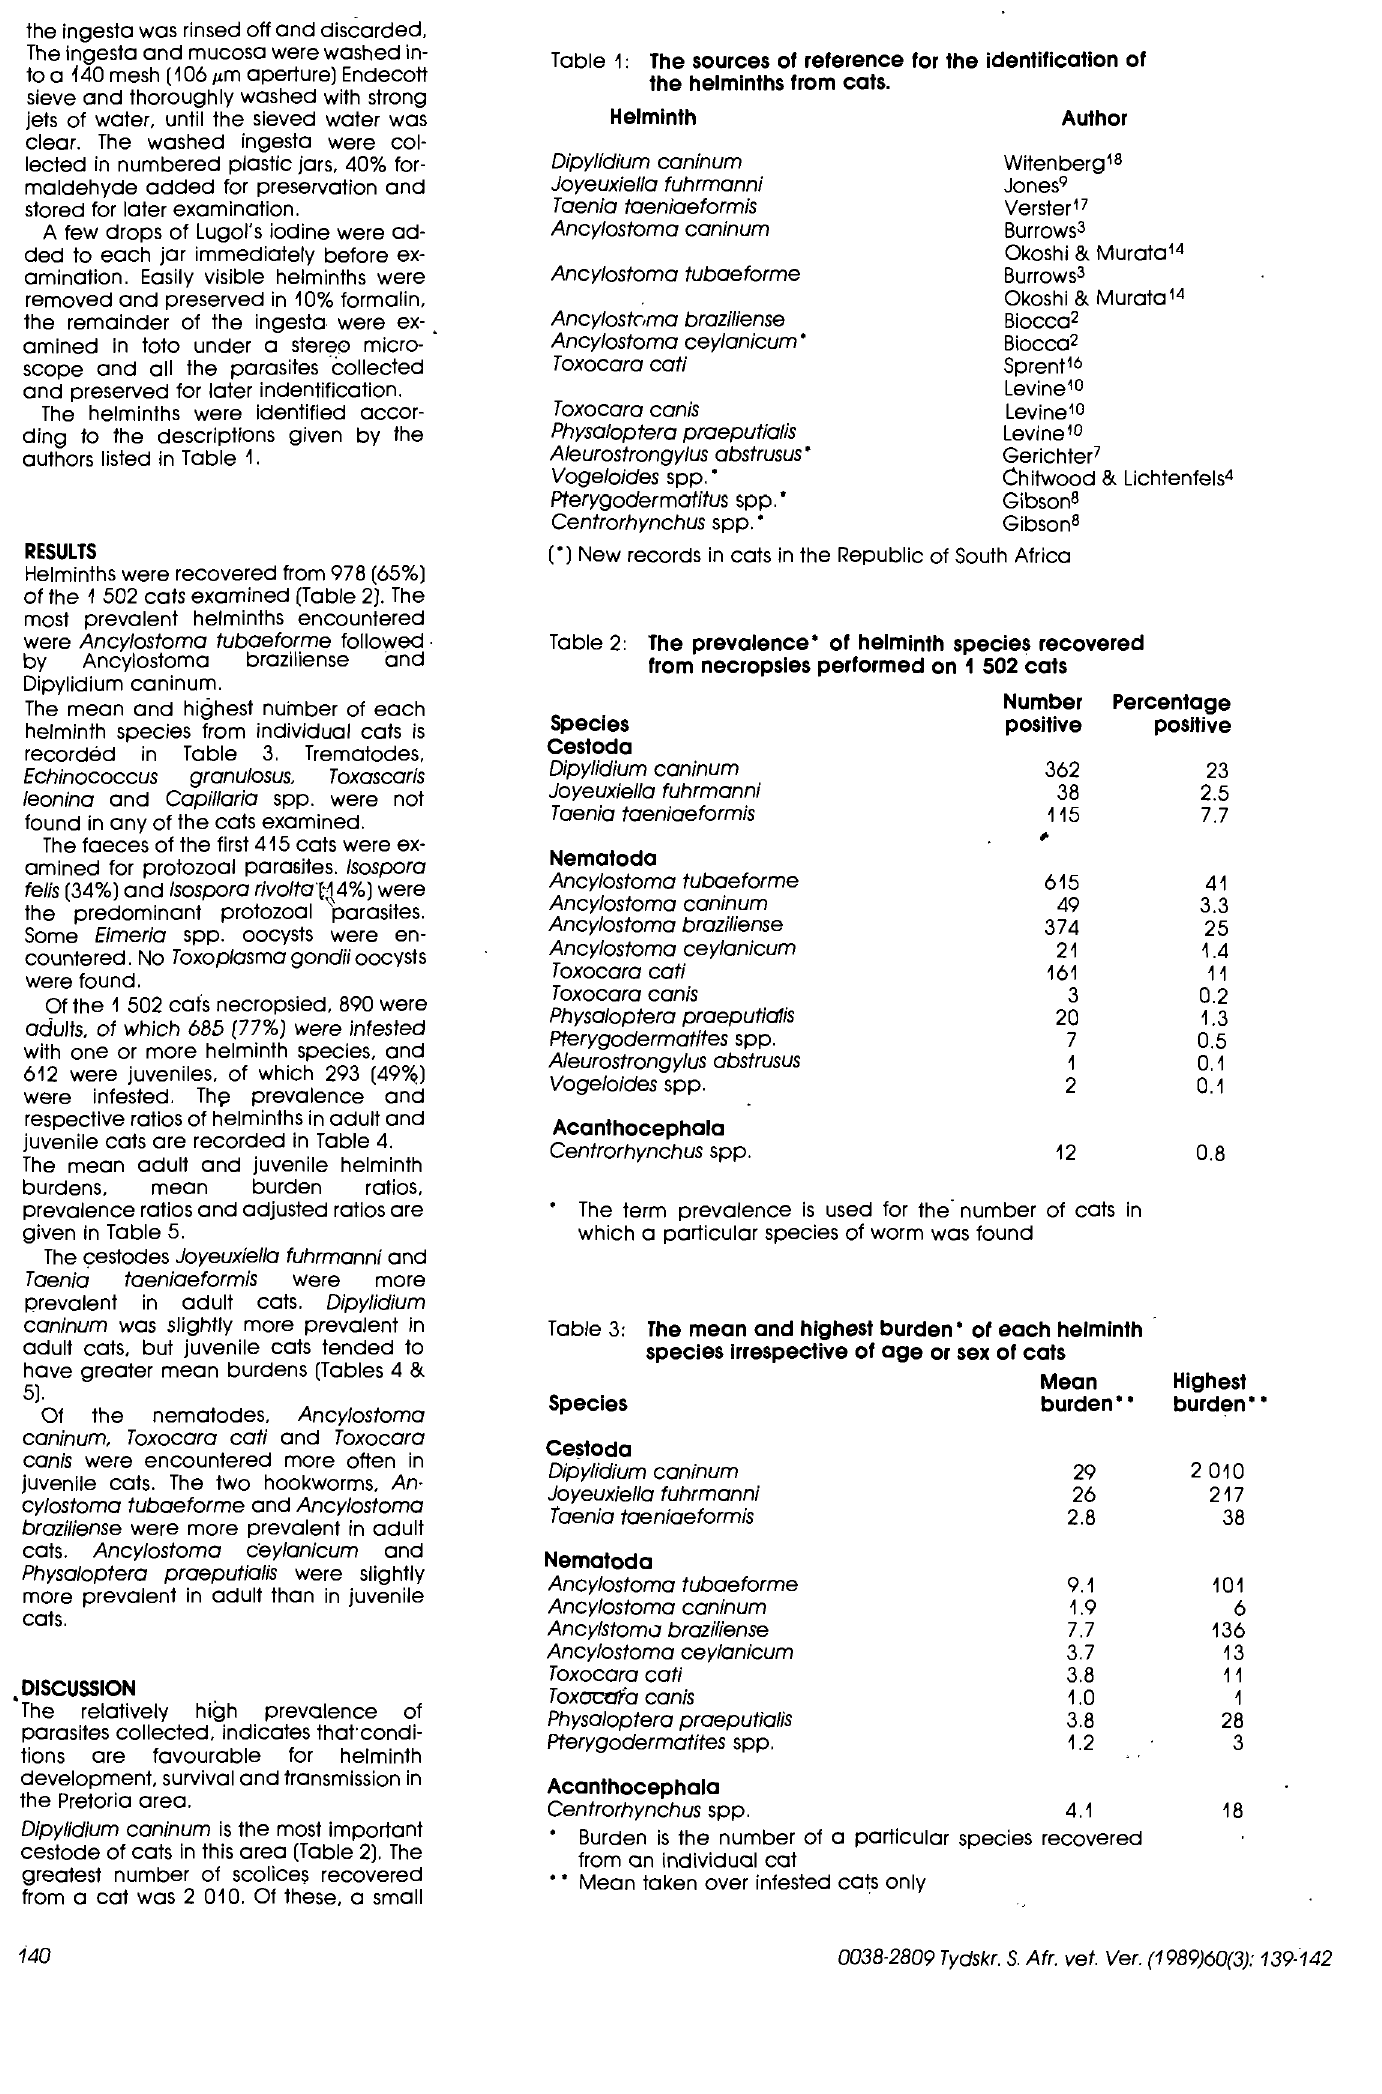
Table 1: The sources of reference for the identification of the helminths from cats. Helminth